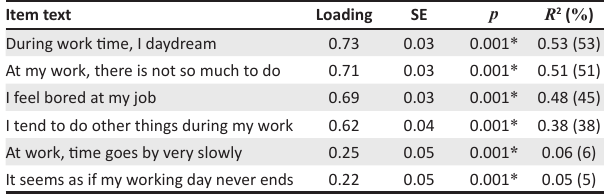
TABLE 2: Standardised factor loadings of the items for the latent workplace boredom variable.